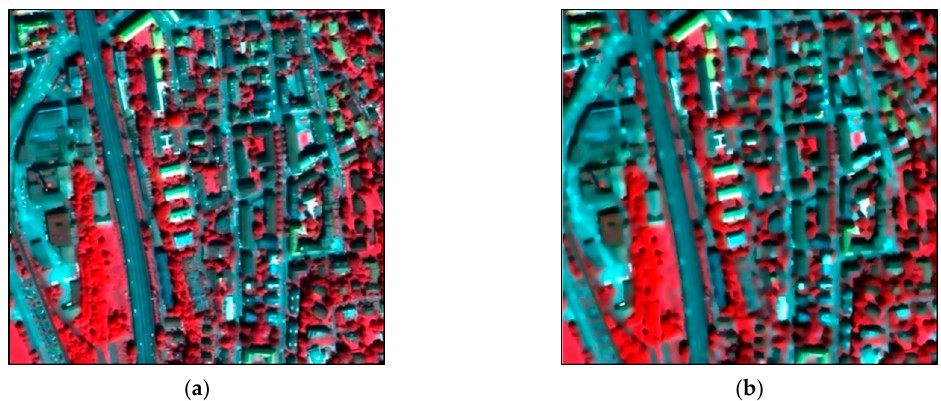
Figure 7. Visual comparison (Bands: 4, 3, 2) of: ( a ) pixel-level guided filter (PGF) features and ( b ) SGF features with the scale of r = 6.